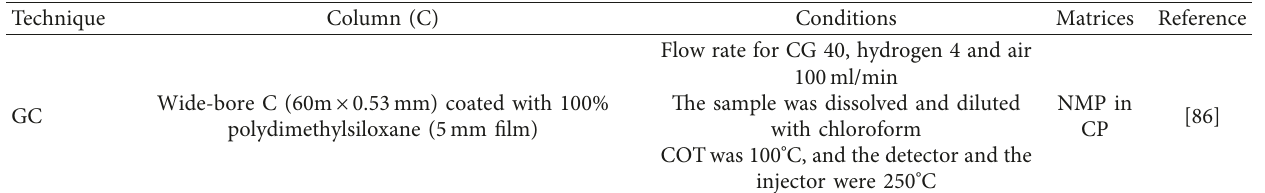
Table 6: Gas chromatographic methods for detection of